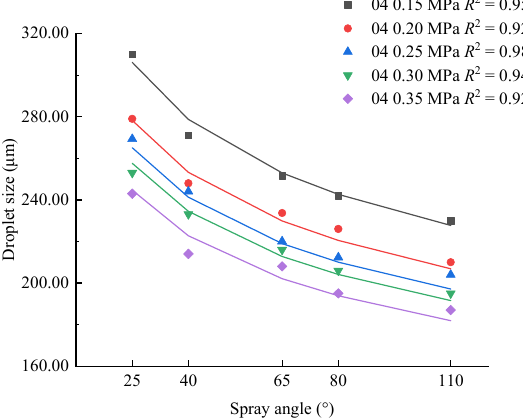
Figure 8. Fitting curves and values of droplet size vs. spray angle. As can be seen in Figure 6, the droplet size along the Z-axis gradually decreased with the increase in the spray pressure. According to the Bernoulli equation, the droplet velocity at the nozzle outlet increases with the increase in the spray pressure, causing the liquid film to break to produce smaller droplets. The fitting function between the droplet size along the Z-axis and the spray pressure is represented as